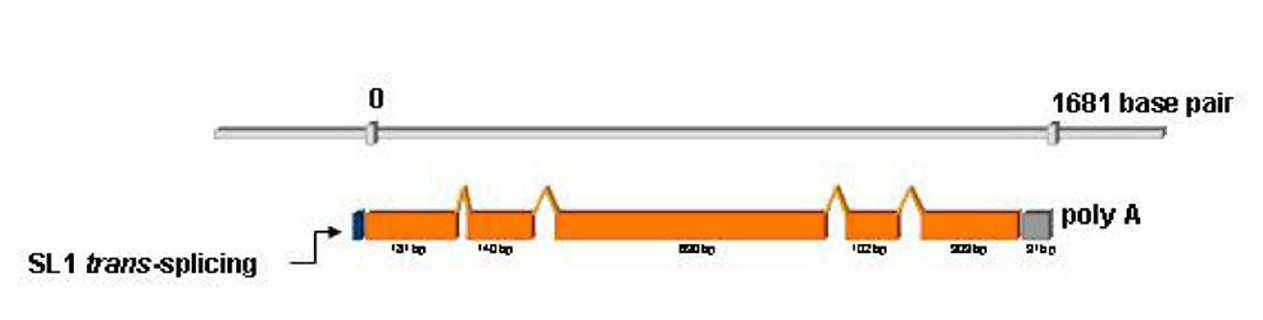
Figure 1 gana-1 gene structure. Schematic representation of gana-1 gene structure. The length of genomic DNA from start to stop codons is 1681 bp. The spliced cDNA consists of 1356 bp + 91 bp of 3'